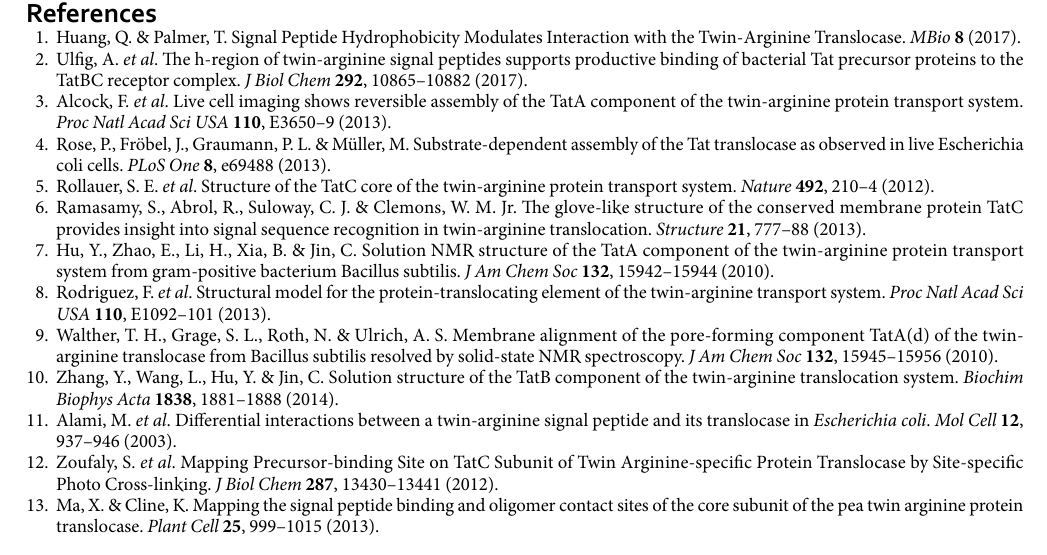
in a cell free transcription/translation system in 50 μ l reactions 44 . Cell extracts were prepared using E. coli strain SL119 45 or Top10 (Invitrogen) transformed with plasmid pSup-BpaRS-6TRN(D286R) for Bpa incorporation into TorA-MalE335. The vesicles were added 12 min after starting protein synthesis at 37 °C and incubated for 18 min at 37 °C. In order to disrupt the proton motive force, 0.1 mM CCCP was added at the onset of synthesis. After incubation with vesicles, Bpa crosslinking was induced by UV irradiation for 20 min on ice. To visualize transport of TorA-MalE335 into the vesicles, completed reactions were treated with 0.5 mg/ml Proteinase K. For immuno-precipitation, the samples were denatured in 1% SDS for 10 min at 95 °C after crosslink- ing. Antisera against TatA, TatE and TatB were incubated with Protein A-Sepharose beads for 90 min at 4 °C.